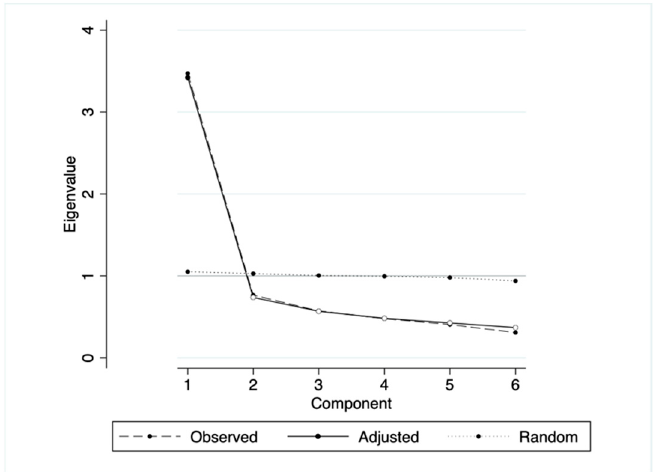
Figure 2. Scree parallel plot.